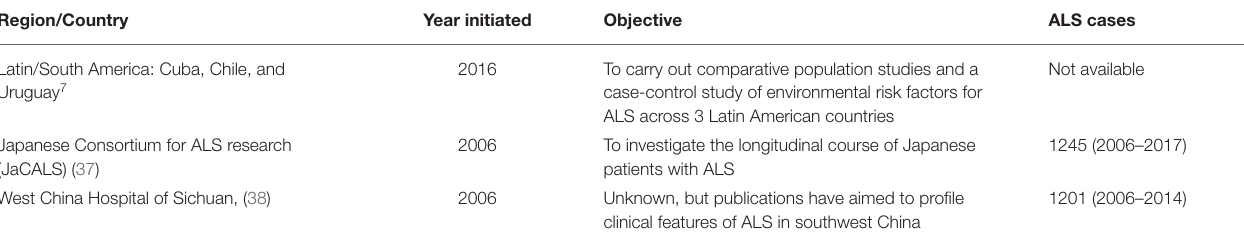
TABLE 3 | ALS registries and collaborative research platforms in Latin America, South America, Japan, and